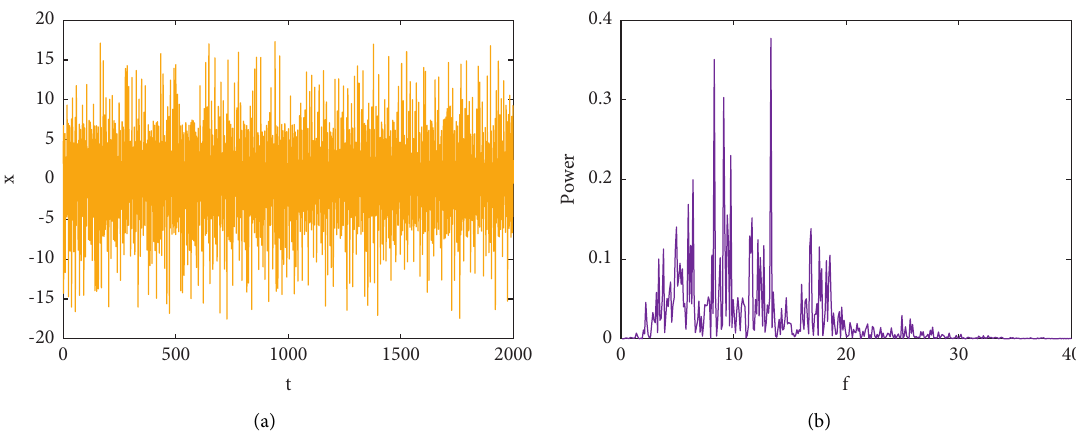
Figure 3: (a) Chaotic time series of the Rucklidge system for the x signal. (b) Apparently continuous broadband power spectrum. Note: ( a,b ) � ( 2 , 9 . 3 ) .